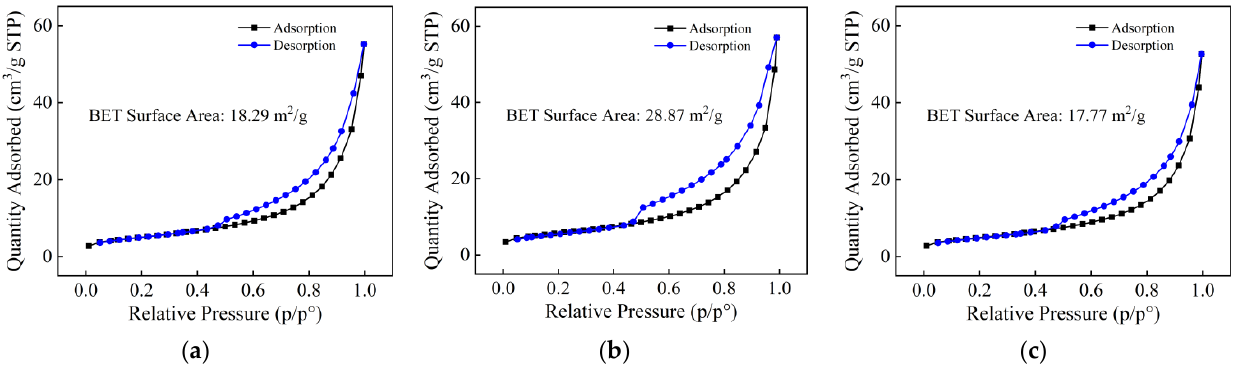
Figure 7. 1-day BET specific surface area of cement hydration products with nothing ( a ), CNA ( b ) and TEA ( c ). Table 4. The C-S-H content calculation results and BET data statistics of each group.